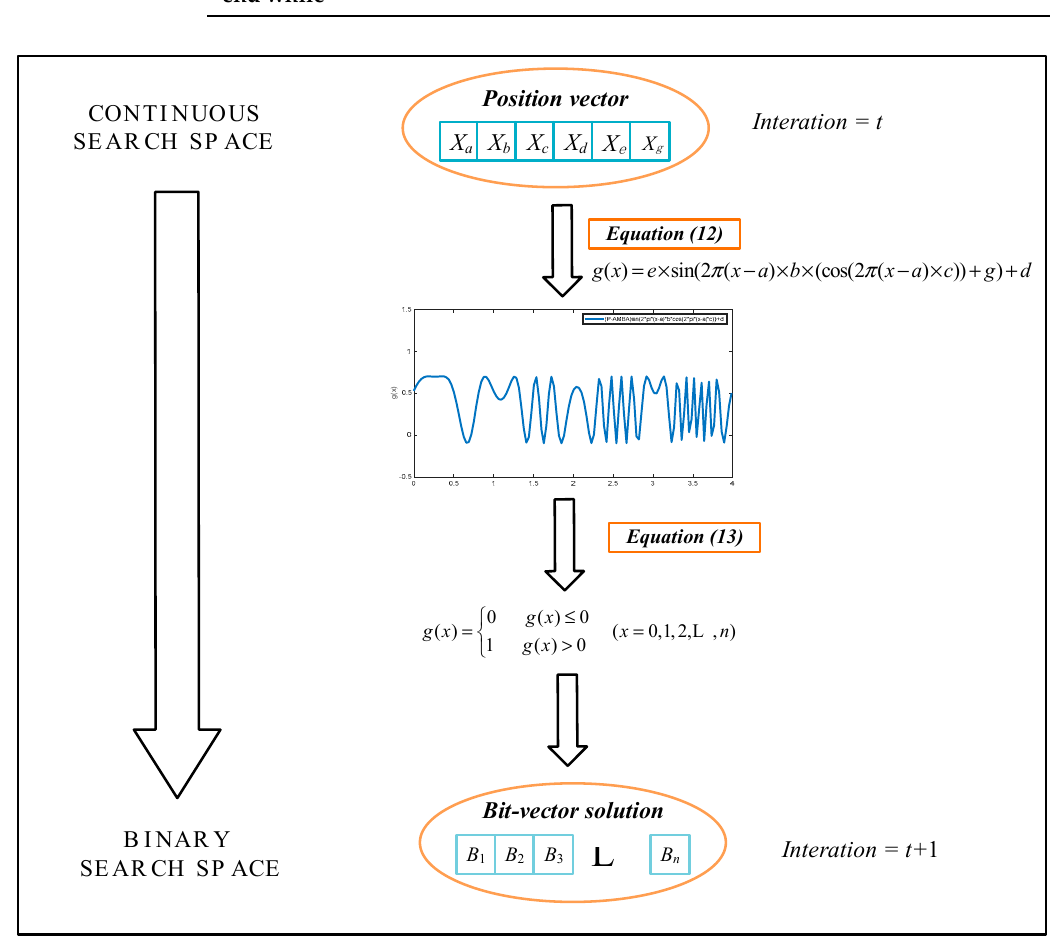
Figure 4. The process of mapping continuous search space to discrete search space.